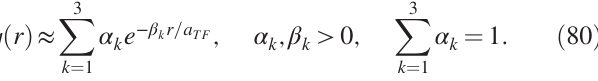
- e a =Z and K ¼ B